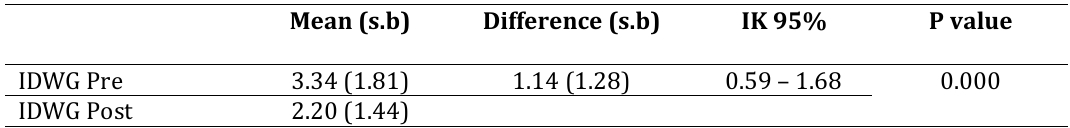
Table 4 The Effect of Using the Fluid Balance Application on Interdialytic Weight Gain Status in Chronic Kidney Disease Grade V Patients Undergoing Hemodialysis at the Kidney and Sustainable Hypertension Clinic October 2022